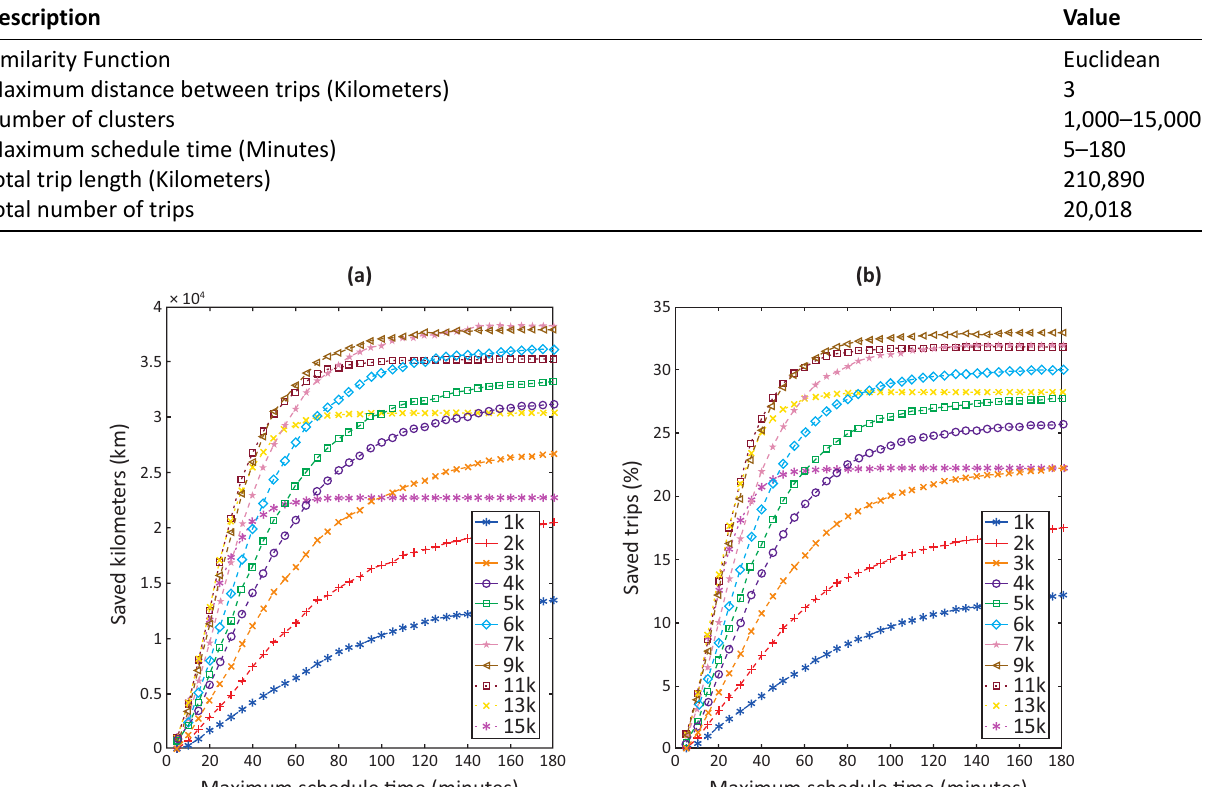
Table 4. Simulation set up parameters (case study 4).